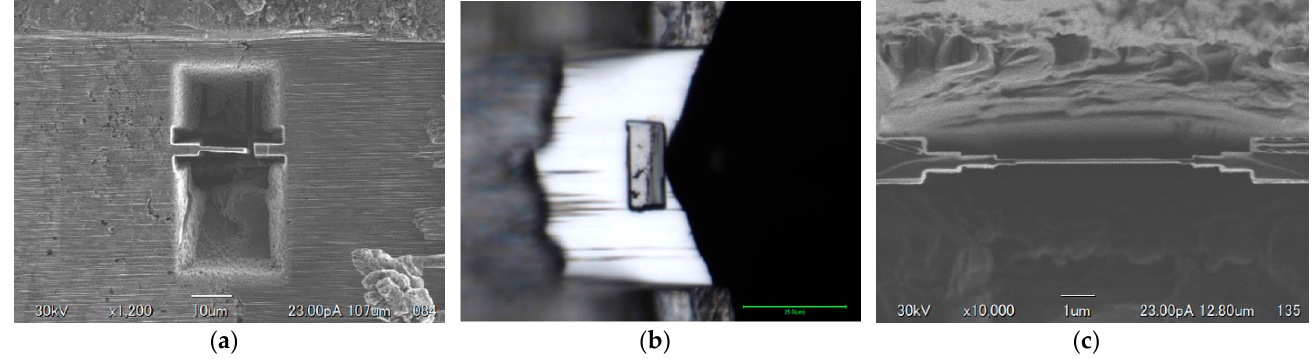
Figure 2. Images illustrating bulk pickup method ( a ) side cut ( b ) after pickup and ( c ) thinning to 90 nm.